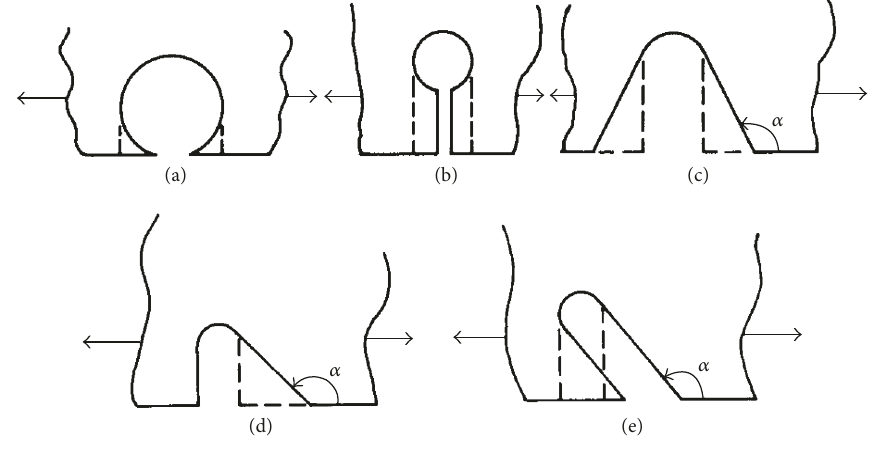
Figure 16: Equivalent notch configurations